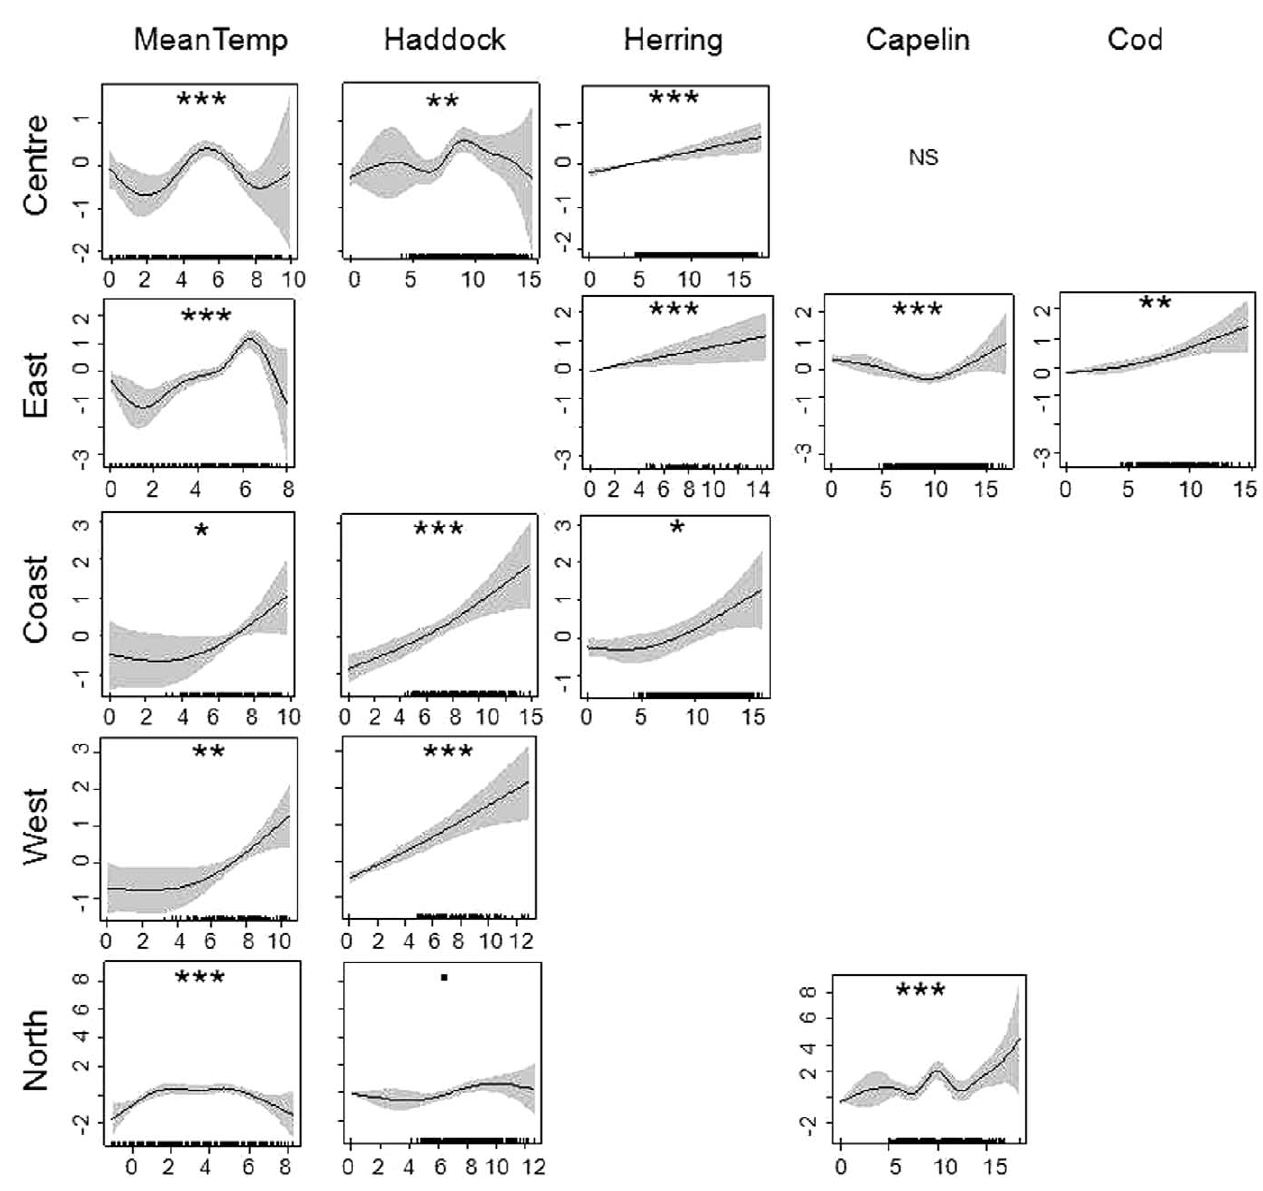
Figure 6. Estimated functions for jellyfish and prognostic factors (mean temperature (MeanTemp) and 0-group fish (haddock, herring, capelin and cod) densities). Jellyfish biomass shows at y-axis, while prognostic factors at x-axis. Separate models were performed for the coastal, central, eastern, western, and northern areas codes are shown: 0.001 as ‘‘***’’, 0.01 as’’**’’, 0.05 as ’’*’’, 0.1 as’’ . ’’, and not significant means as Ns. doi:10.1371/journal.pone.0033050.g006 PLoS ONE |